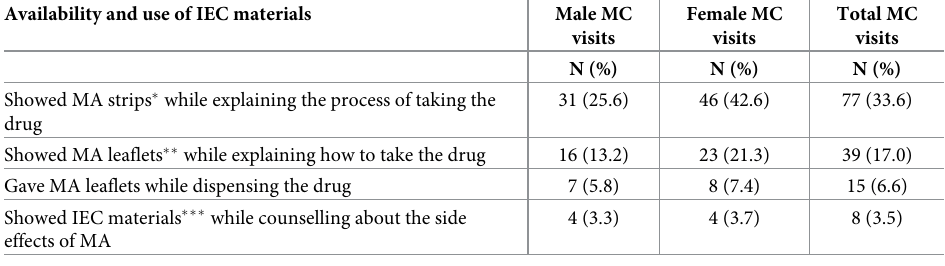
Female MC Total MC visits visits visits N (%) N (%) N (%) 31 (25.6) 46 (42.6) 77 (33.6) 4 (3.3) 8 (3.5)